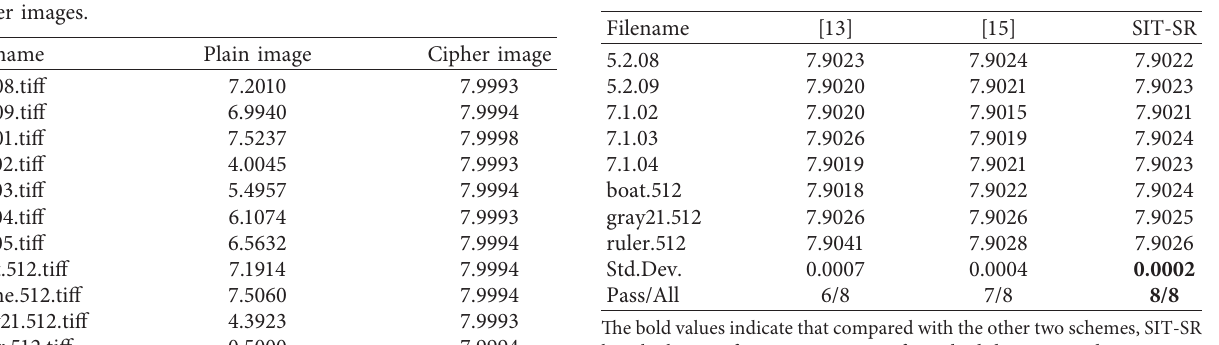
Table 10: LSE test results of different